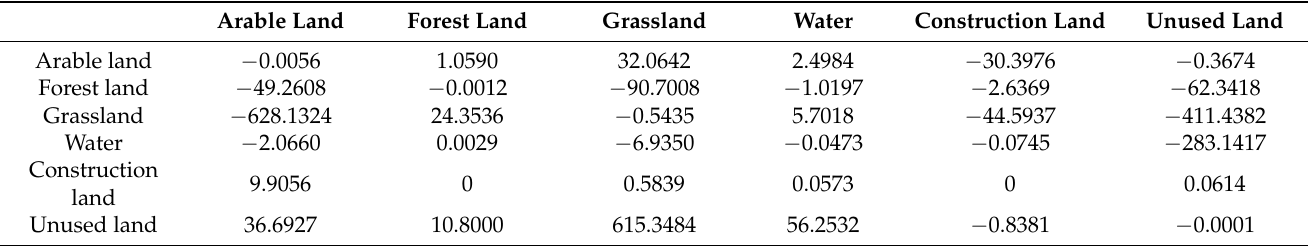
Table 5. HQ change index (HQCI) values of land use conversions from 1980 to 2020 in Wusu, China. Arable Land Forest Land Grassland Water Construction Land Unused